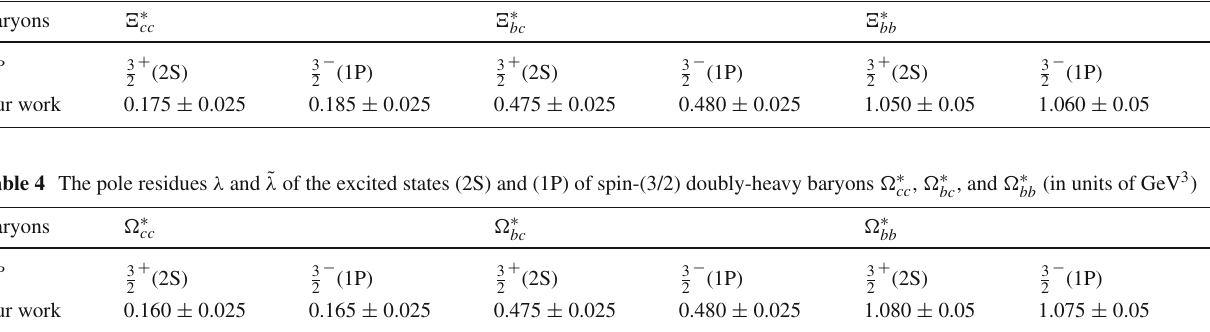
, and (cid:2) ∗ (in units of GeV 3 ) bc bb